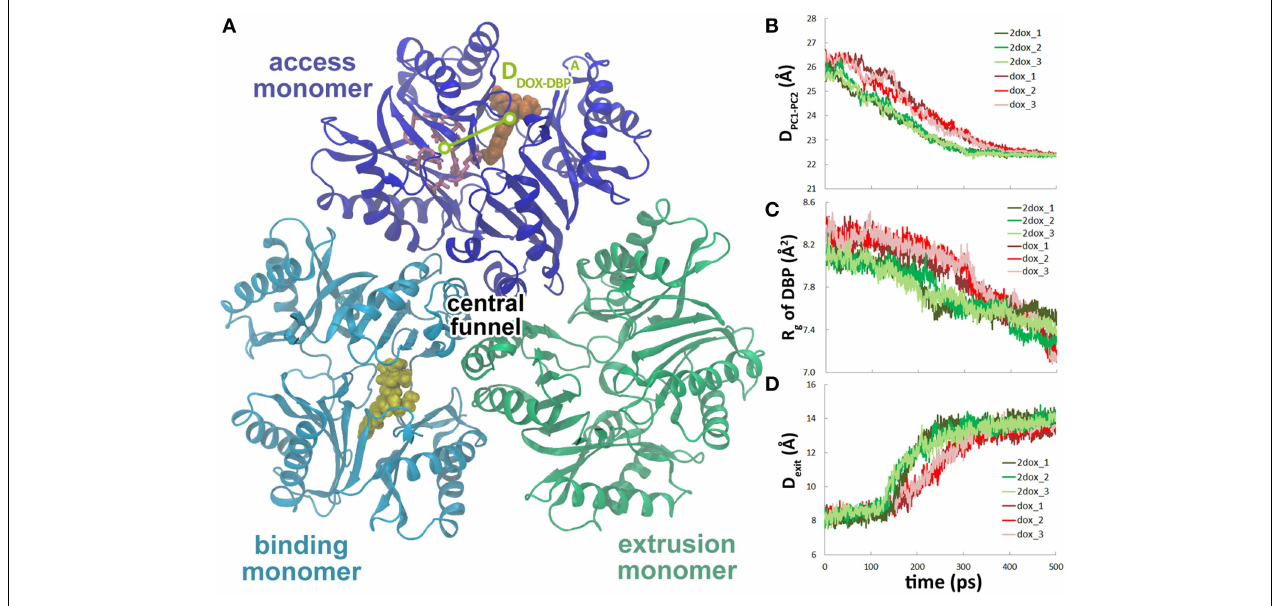
the distance between the mass centers of PC1 and PC2 subdomains of B monomer in dox and 2dox systems. (C) Comparison of the variations of R g of the DBP of B monomer in dox and 2dox systems. (D) Comparison of the variations of the Gln124-Tyr758 inter-residue distance at the exit region of B monomer in dox and 2dox systems.